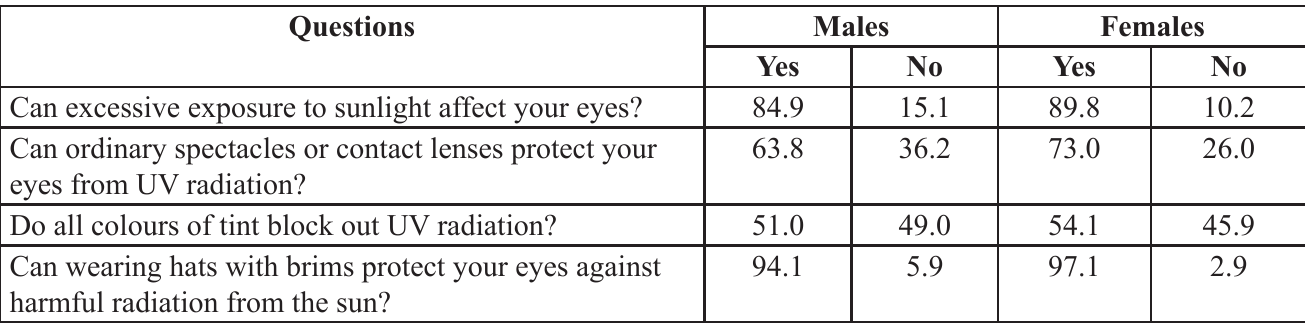
Table 4: Showing the percentages of each gender who responded to the questions indicated (intra-gender or within gender re- sponses). More of the female respondents gave correct